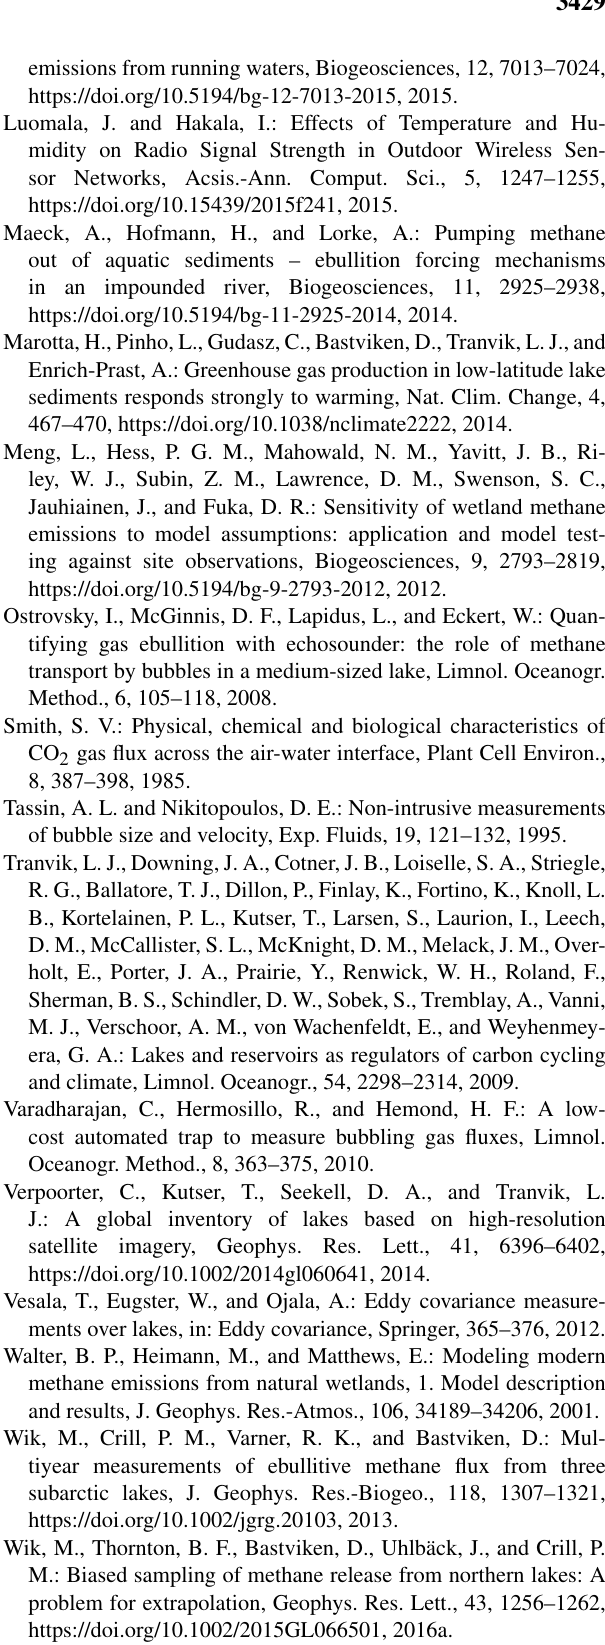
Figaro TGS 2611 – for the detection of Methane: avail-